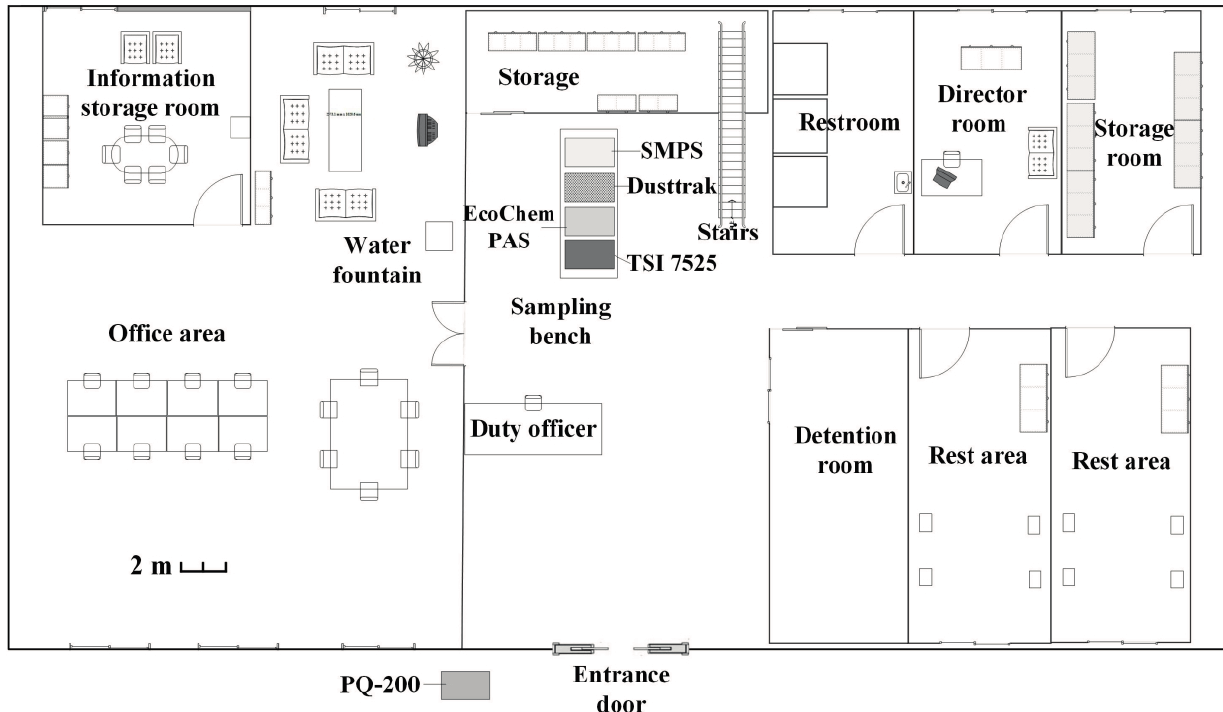
Figure 2. Layout of the police station. The instruments were placed on the sampling bench located right behind the duty officer and in front of